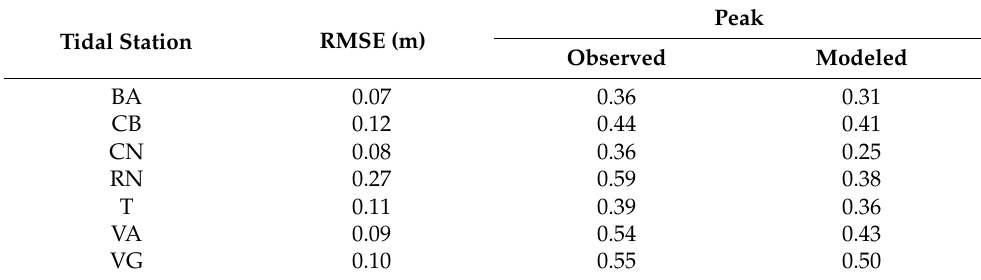
Table 8. Model performance under storm surge propagation resulting from the validation procedure. Tidal Station RMSE (m)